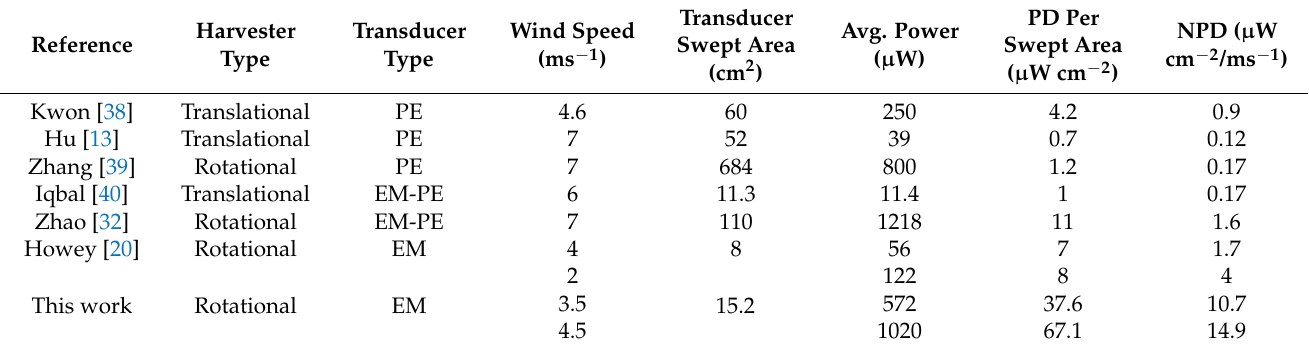
Table 3. Performance comparison among various similar wind energy